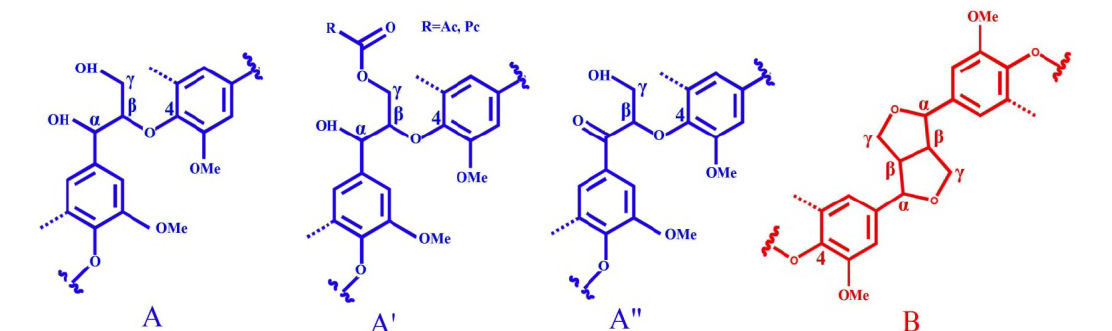
Figure 6. Main structures present in bamboo lignin: ( A ) β -O-4 alkyl-aryl ethers; ( A ') β -O-4 alkyl- aryl ethers with acylated γ -OH with p -coumaric acid; ( A '' ) Cα - oxidized β -O-4' structures; ( B ) resinols; ( B ') tetrahydrofuran; ( C ) phenylcoumarans; ( D ) spirodienones; ( E ) α,β -diaryl ethers; ( T ) a likely incorporation of tricin into the lignin polymer through a G-type β -O-4 linkage; ( I ) p -hydroxycinnamyl alcohol end-groups; ( I ') p -hydroxycinnamyl alcohol end- groups acylated at the γ -OH; ( J ) cinnamyl aldehyde end-groups; (PCA) p -coumarates; (FA) ferulates; ( H ) p -hydroxyphenyl units; ( G ) guaiacyl units; ( S ) syringyl units; ( S ') oxidized syringyl units bearing a carbonyl at C (Reprinted from [28]. Copyright 2013 De α